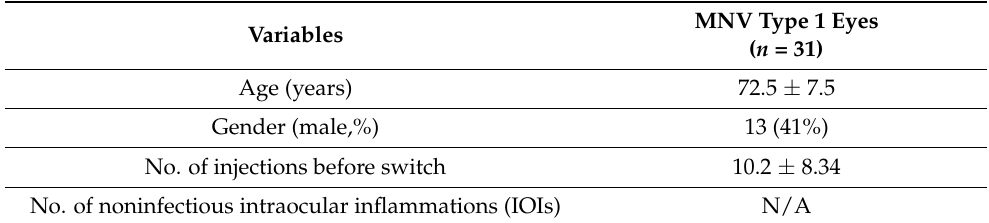
Table 1. The clinical characteristics of the subjects included in the analysis. Quantitative data are presented as mean ± SD (standard deviation).